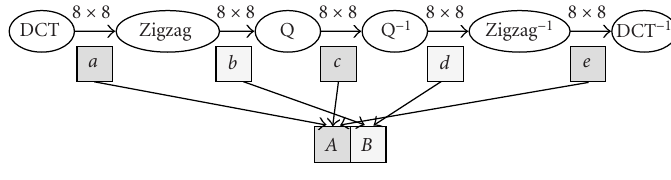
Figure 2: Image processing